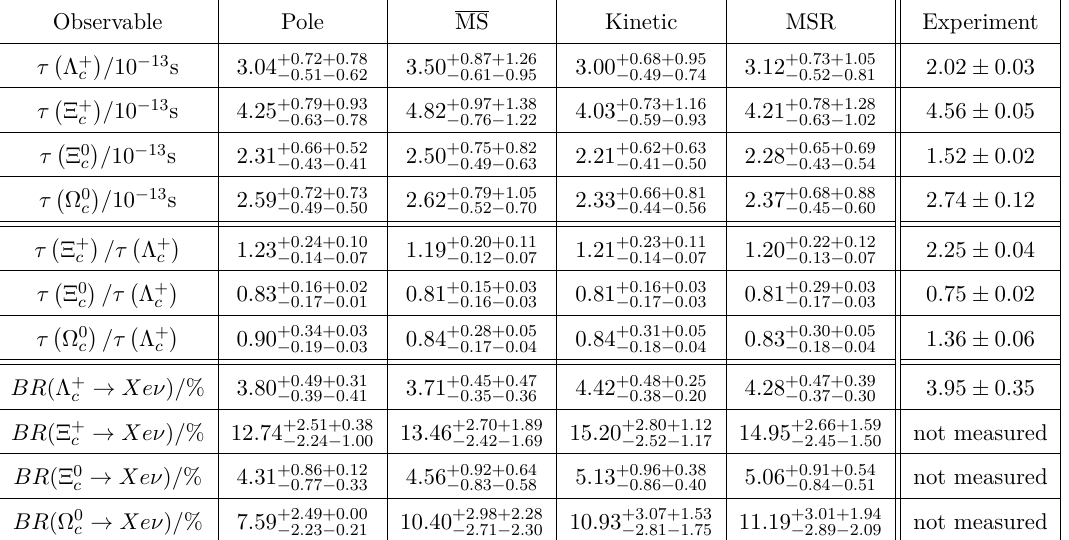
Table 14. Results for baryons in different mass schemes, including the lifetimes, lifetime ratios compared to the Λ + , and semileptonic branching fractions. The lifetime ratios are determined using c eq. (5.19), and the semileptonic branching fractions using eq. (5.20). The first and second errors correspond to hadronic and renormalization scale uncertainties, respectively. As for mesons, central values correspond to the scale choice µ = µ = 1 . 5 GeV, while the scale uncertainties are estimated 0 for fixed values of the hadronic parameters by varying the scale µ in the range [1 , 3] GeV.